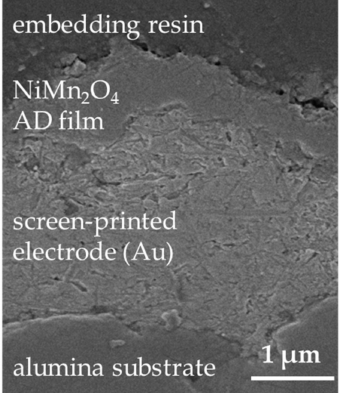
Figure 5. Cross-section of an NTCR component, consisting of a NiMn 2 O 4 AD film on screen-printed Au electrodes on alumina substrate, after being tempered under cycle